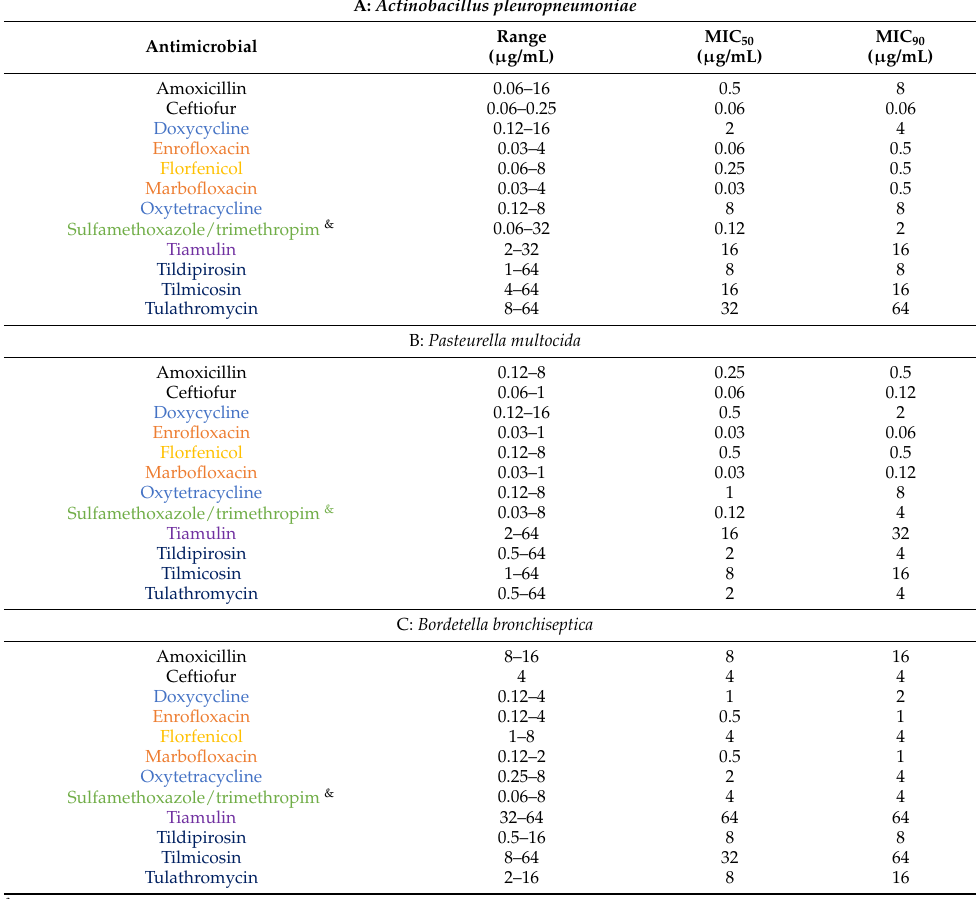
Table 1. Actinobacillus pleuropneumoniae (A), Pasteurella multocida (B) and Bordetella bronchiseptica (C) MIC range, MIC 50 and MIC 90 for 490 APP, 285 PM and 73 BB strains, respectively, isolated from respiratory clinical cases. The same color in the antimicrobial column represents member of the same antimicrobial